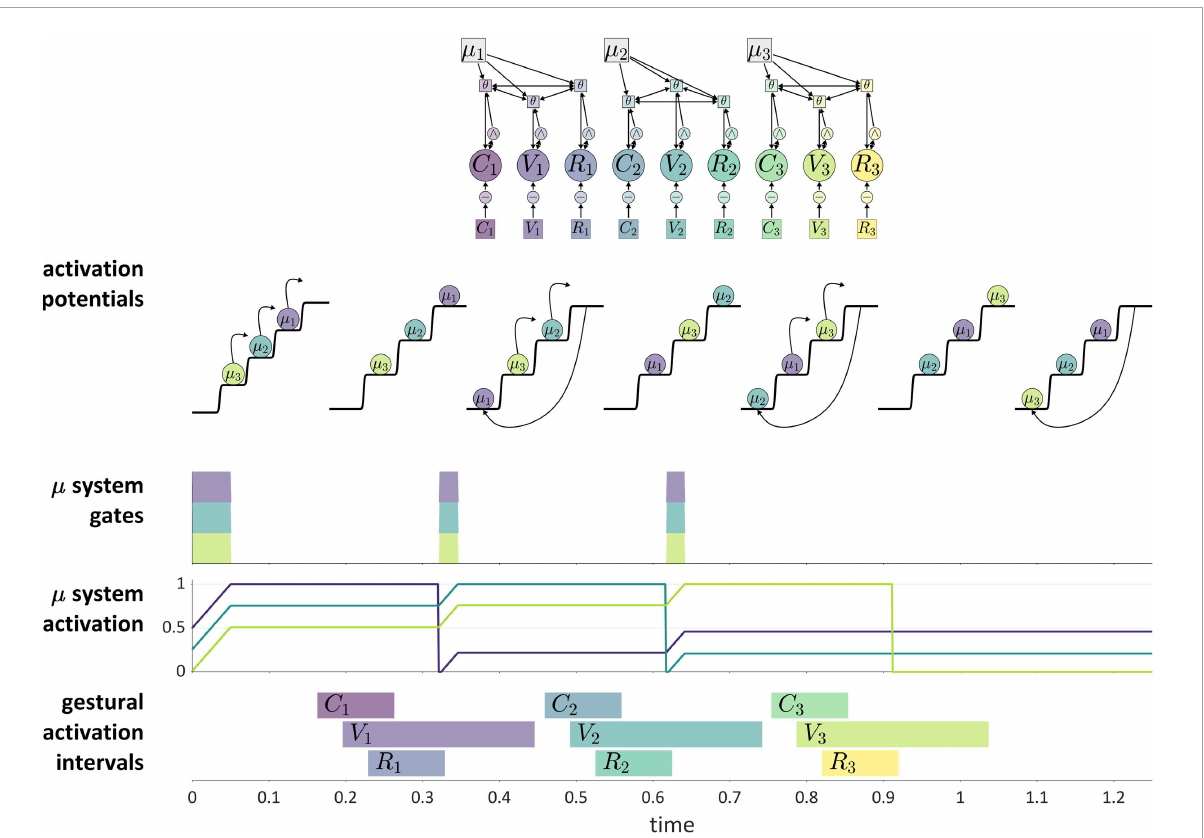
FIGURE11 Illustration of competitive selection for a sequence of three CV syllables. (Top) Model schema. Activation potentials with arrows show transitions between states, and potentials without arrows shown quasi-steady states. µ -gating system states are shown (shaded intervals are open states). (Bottom) Gestural activation